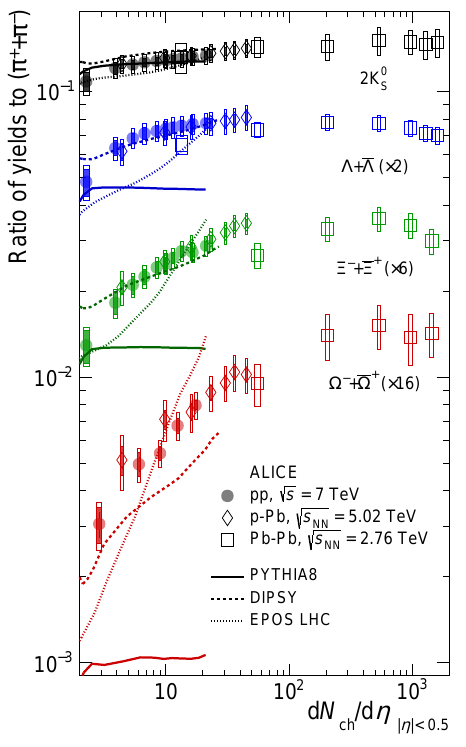
Figure 5. pt-integrated yield ratios to pions ( π + + π − ) as a func- tion of (cid:104) d N ch / d η (cid:105) measured in | y | < 0 . 5. The error bars show the statistical uncertainty, whereas the empty and dark-shaded boxes show the total systematic uncertainty and the contribution un- correlated across multiplicity bins, respectively. The values are compared to calculations from MC models [3, 18, 19] and to re- sults obtained in pp and pPb collisions at the LHC [20–22]. For PbPb results, the ratio 2 Λ / ( π + + π − ) is shown. The indicated un- certainties all represent standard deviations. Picture and caption are taken from [6].